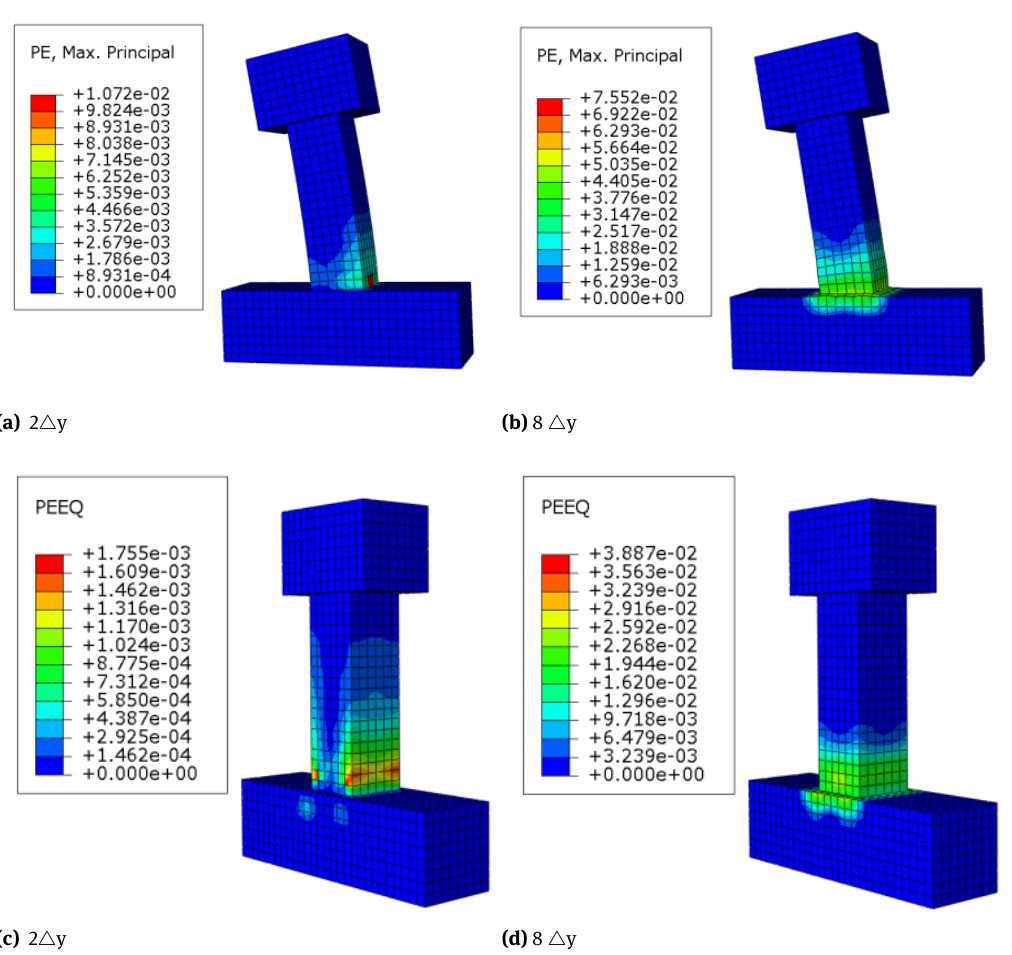
Figure 14: Nephograms of Equivalent Plastic Strain and Maximum Principal Plastic Strain of